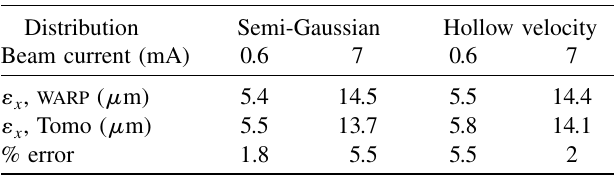
TABLE I. Summary of emittance measurements for different input distributions and beam currents.